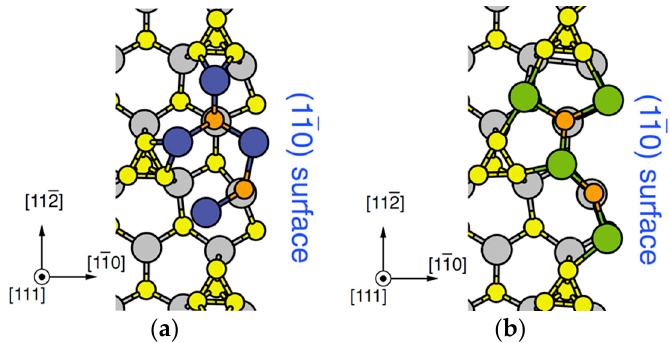
Figure 19. Top views of ( a ) 4In-2P occupying the ZB lattice sites (4In-ZB-2P) and ( b ) 4In-2P occupying the WZ lattice sites (4In-WZ-2P) near the side facet. There is a two-coordinated In adatom indicated by the red circle in 4In-ZB-2P, whereas all the In adatoms in 4In-WZ-2P are three-coordinated. The three-coordinated In adatom at the side facet in 4In-WZ-2P is due to the formation of In-P bonds with the P atom in the second layer. Reprinted with permission from [95]. Copyright (2011) by the Japan Society of Applied Physics.